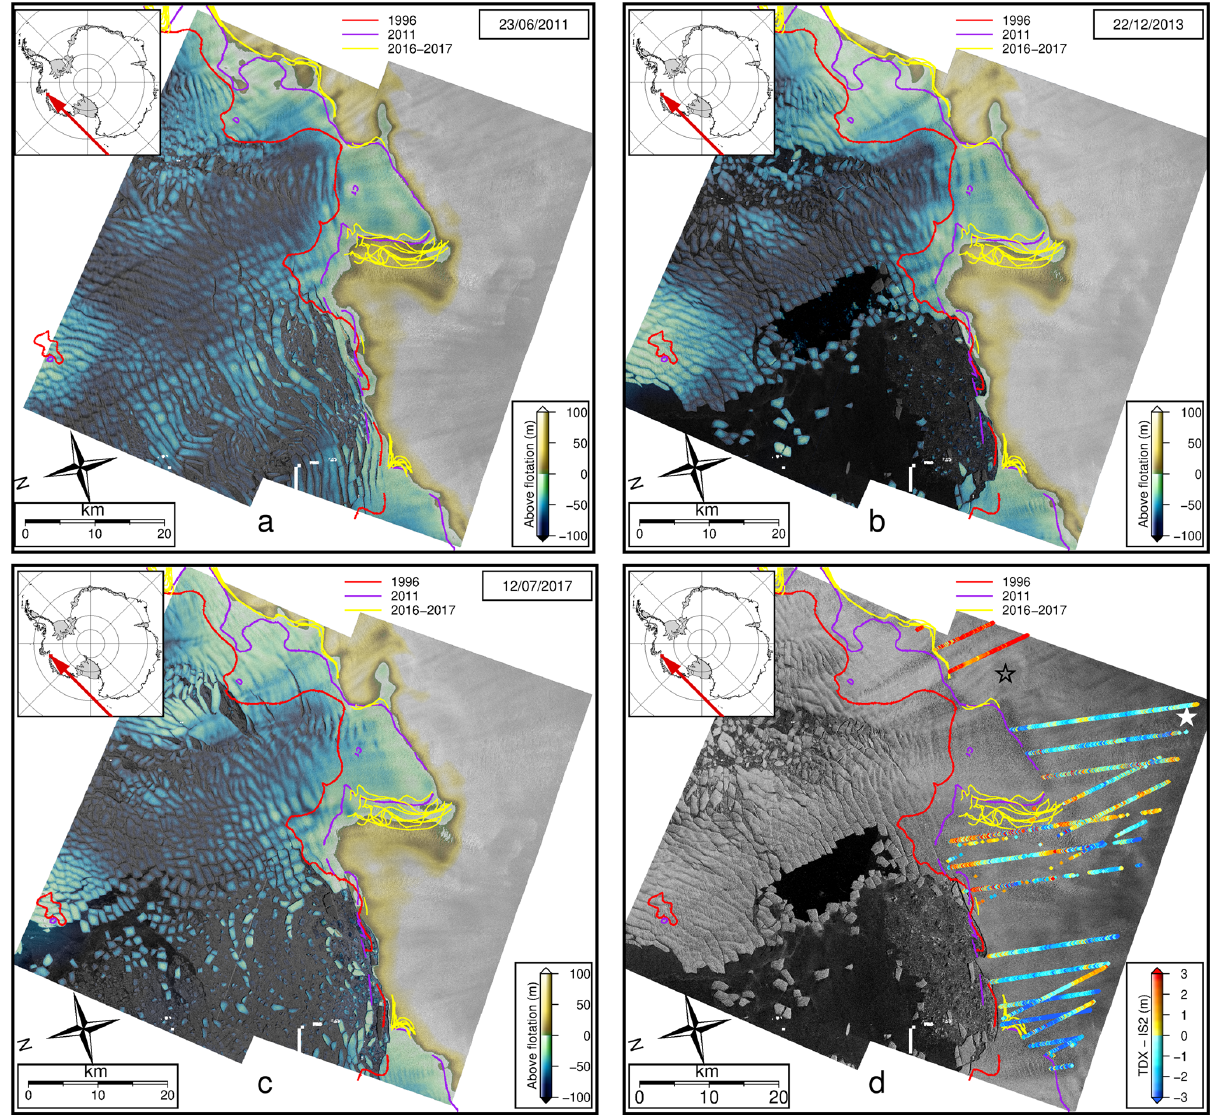
Figure A1. TanDEM-X DEM-derived height above flotation for (a) 23 June 2011, (b) 2 December 2013, and (c) 12 July 2017. MEaSUREs (Rignot et al., 2016) grounding lines in red (1996) and purple (2011) and Milillo et al. (2019) grounding lines in yellow. (d) TanDEM-X elevation minus ICESat-2 elevation for all points over grounded ice, when there was no more than 3d between the TanDEM-X and ICESat-2 acquisitions. Black and white stars mark the tie point locations for each DEM